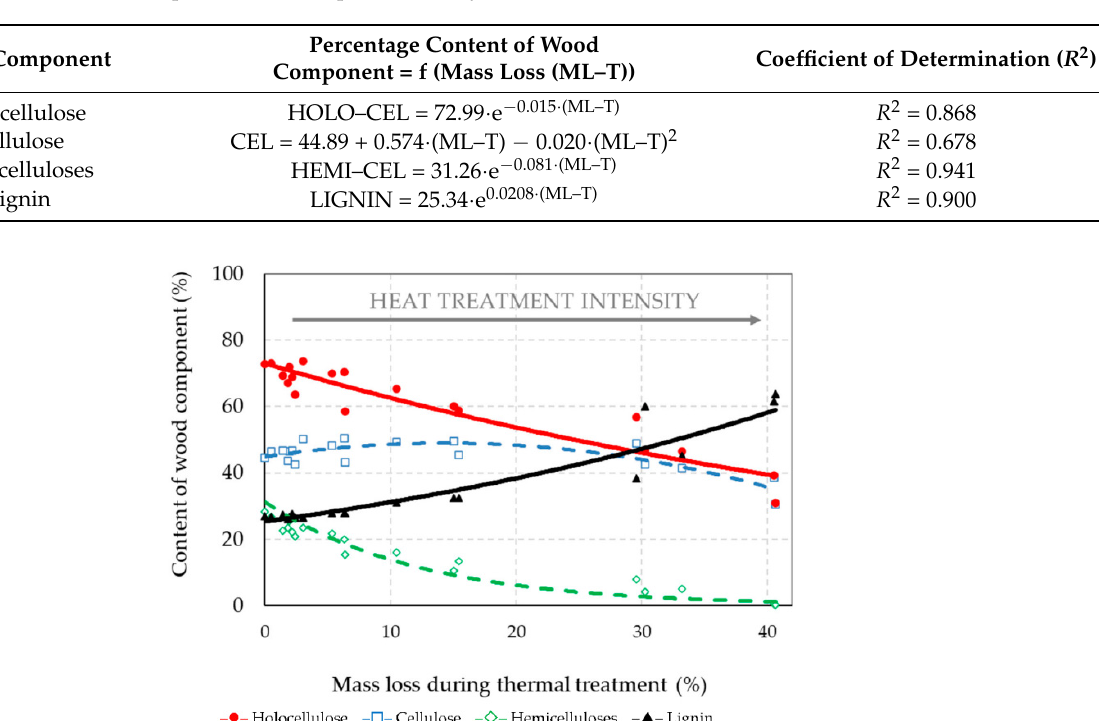
Table 1. Correlations between the content of wood components and the mass loss of the Norway spruce wood samples caused by thermal treatments.